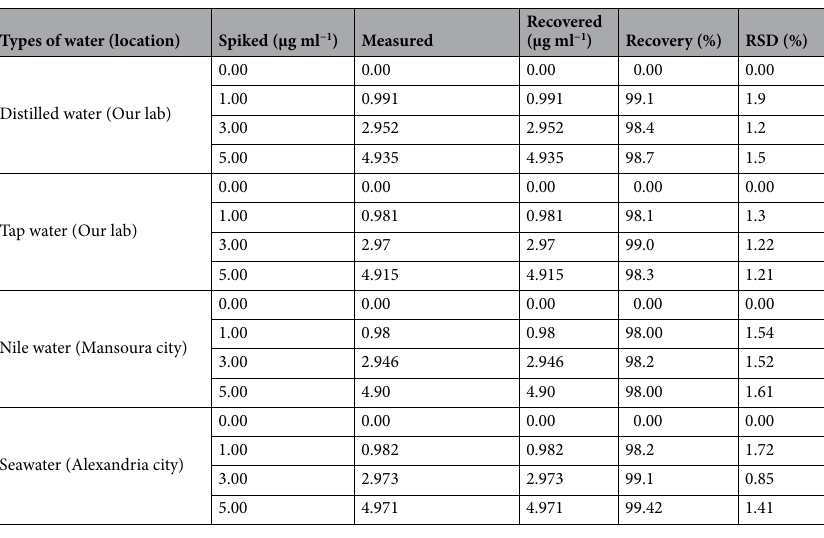
Table 6. Determination of Pd(II) in natural water samples by ICP OES after solvent sublation using 2 × 10 −4 mol l −1 A1, 5 × 10 −4 mol L −1 TBAB, 2 × 10 −4 mol l −1 HOL and 5 ml MIBK at pH 4.0 at room temperature. ( n =